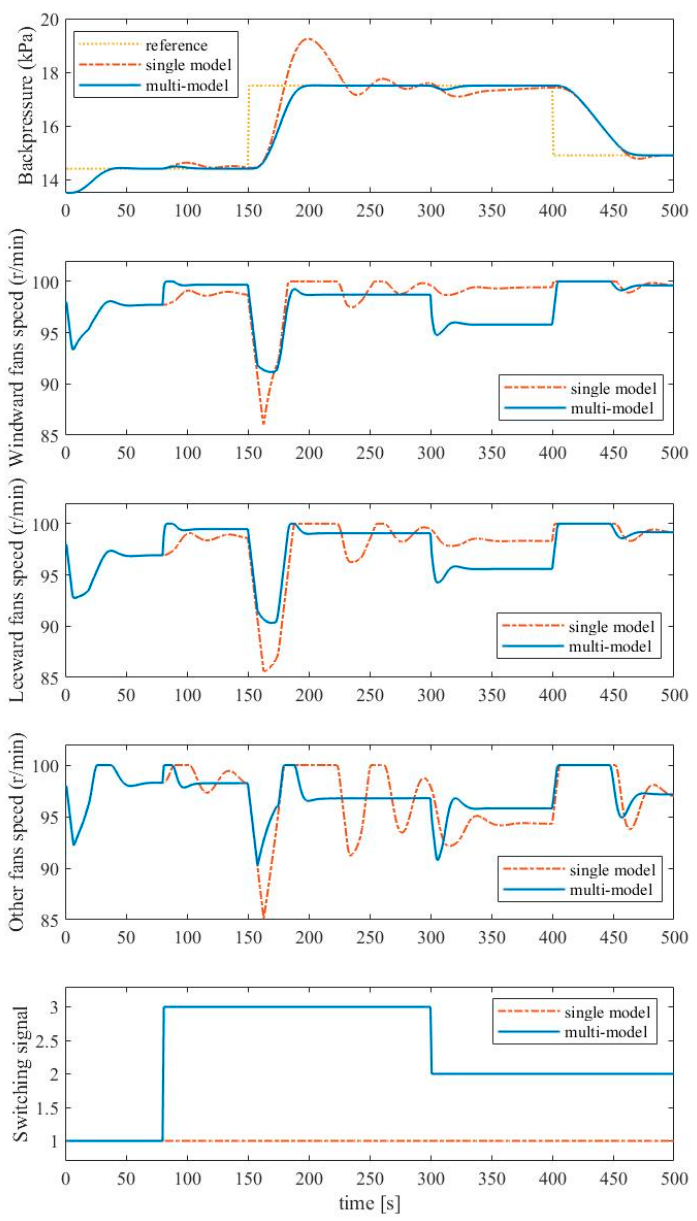
Figure 12. Tracking performance of the multi-model predictive controller.